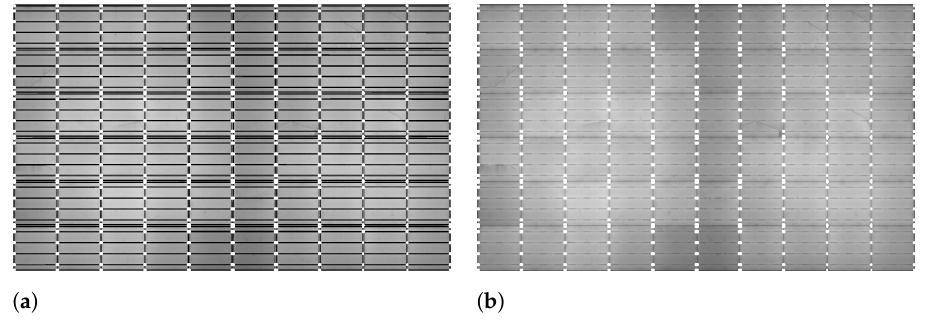
Figure 10. Plotting edge points on panel region. ( a ) Intersection points of horizontal and vertical lines. ( b ) Plotting intersection points on the panel region of EL